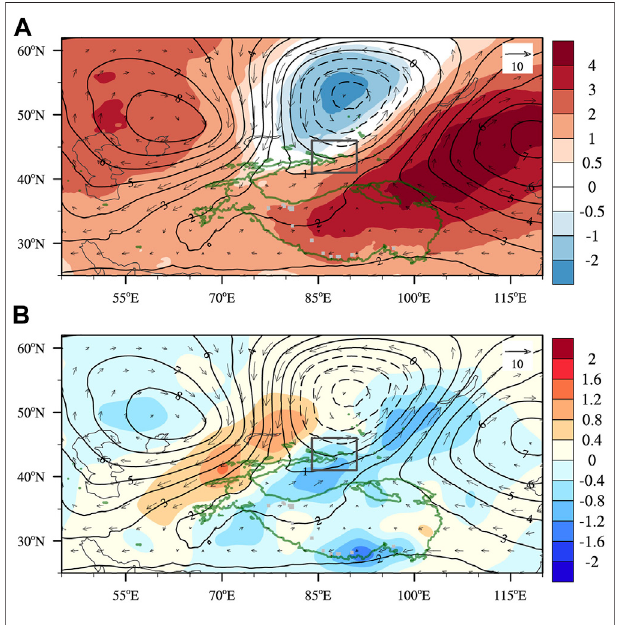
FIGURE10|(A) Differencesbetweenthecompositegeopotentialheight (contours, unit:10 gpm), temperature (shading, unit: K) and horizontal wind fi elds (vectors) at 500 hPa in the cases of Low_Wind and High_Wind (High_Wind minus Low_Wind). (B) is the same as (A) but with the shading denoting the vertical velocity (unit: Pa s − 1 ). The green isolines designatetheelevation of3,000 m,whiletheblackboxesindicatethelocation of the Tianshan Grand Canyon (TGC).